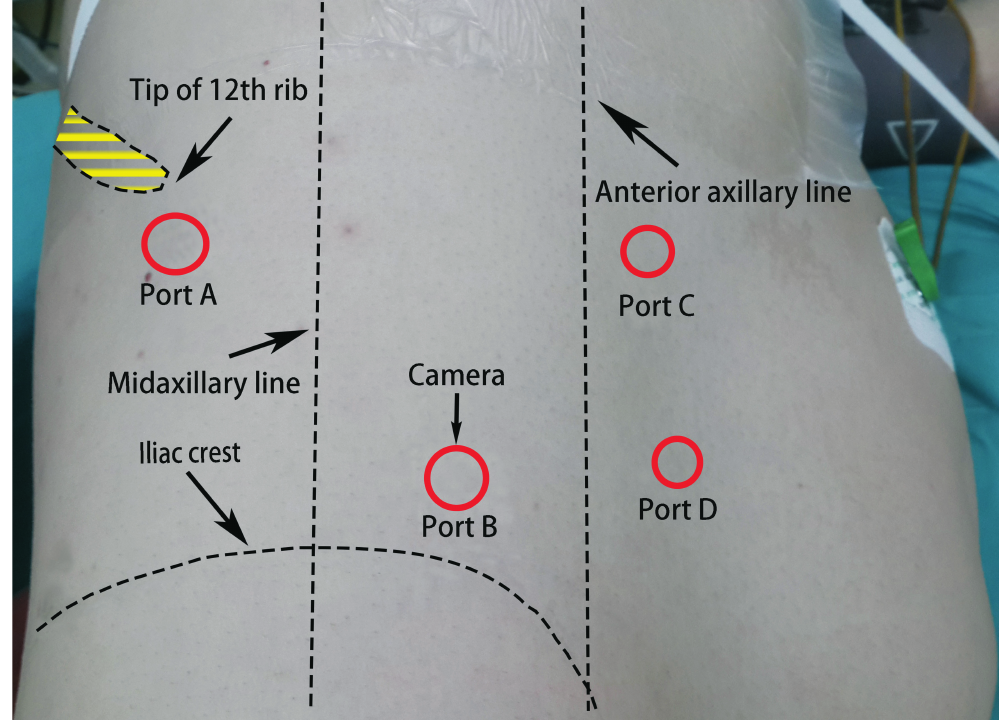
Figure 1 - Patient position and distribution of trocars. The patient was placed in the semilateral decubitus position with the side of the lesion elevated at 60°. Trocar A, below the tip of 12th rib. Trocar B, 2-cm above the superior border of the iliac crest and medial to the midaxillary line. The other two trocars (C and D), along the anterior axillary line and 2–3 cm towards the